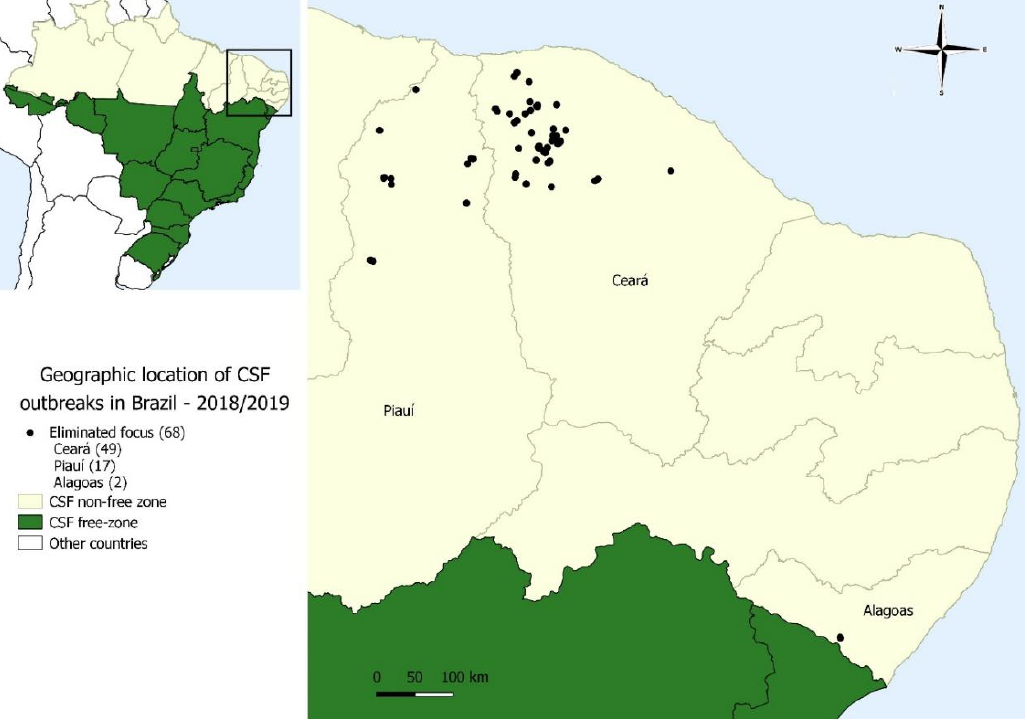
Figure 3. Geographic location of classical swine fever outbreaks in the period from 2018 to 2019 in Brazil (DSA/MAPA, 2019).